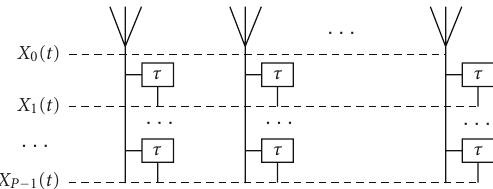
Figure 1: The received signal with delayed output.